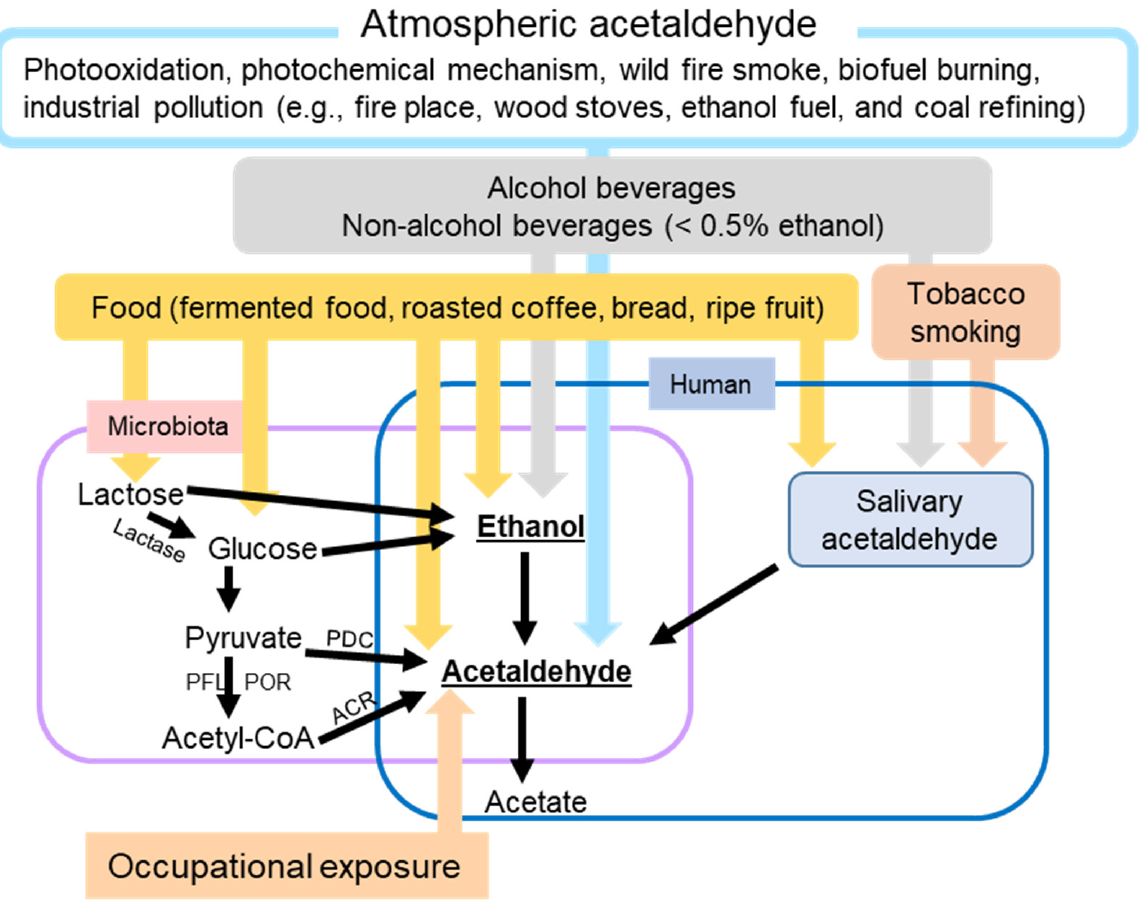
Figure 1. Schematic overview of the major factors leading to human skin exposure to ethanol and/or acetaldehyde. ACR, acetyl-CoA reductase; PDC, pyruvate decarboxylase; PFL, pyruvate formate-lyase; POR, pyruvate ferredoxin oxidoreductase.